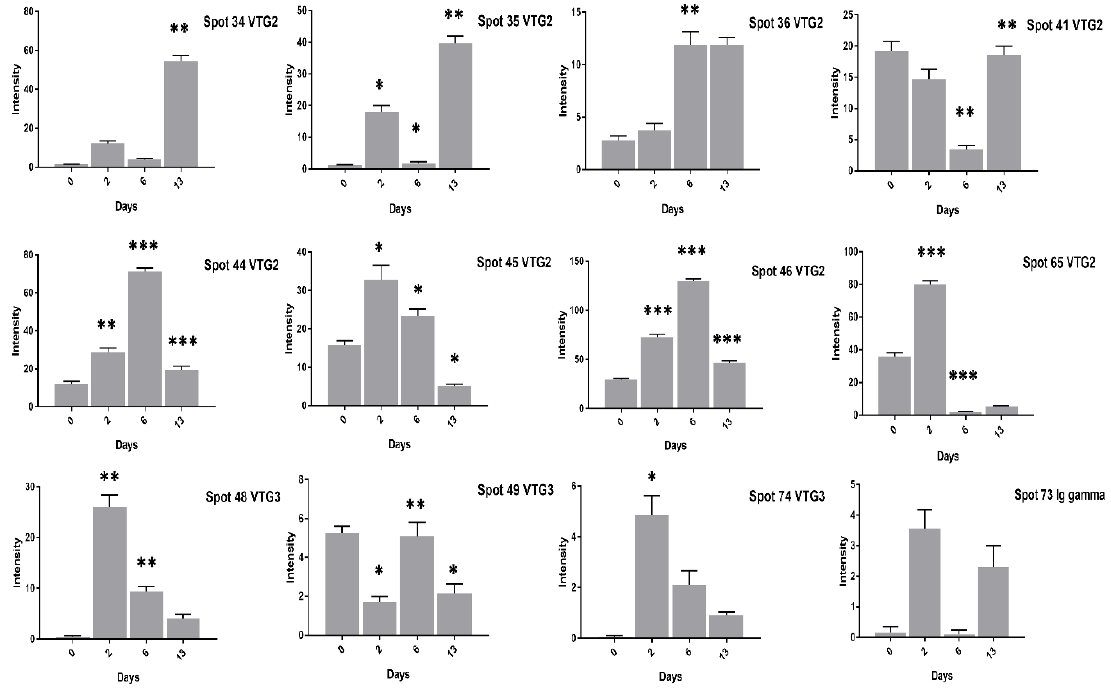
Figure 6. The VTG2, VTG3, and Ig gamma protein spots expression at 0, 2, 6, and 13 days of incubation are shown in low cholesterol eggs. The column profiles of VTG2 spots (34–36, 41, 44–46, 65) and VTG3 spots (48, 49, 74) Ig gamma (73) are indicated as bar charts with significant differences. The error bars represent the standard deviation. * p < 0.05, ** p < 0.005, *** p < 0.0001.